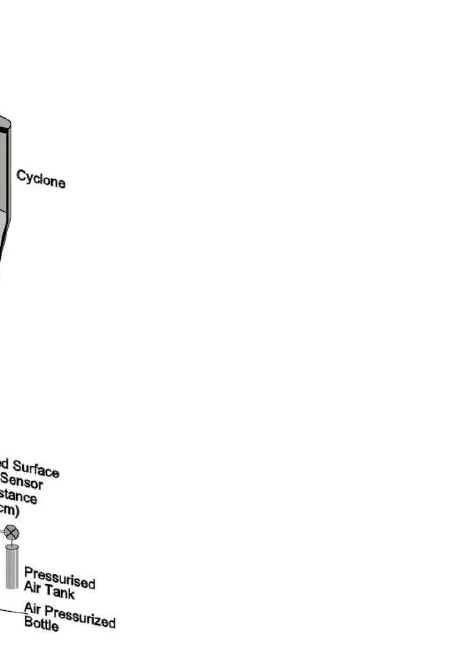
Figure 1. Fluidized bed unit operated at room temperature and near to atmospheric pressure by Torres Brauer (2020) [9]. Details provided show the position of the CREC-Optiprobe sensors.